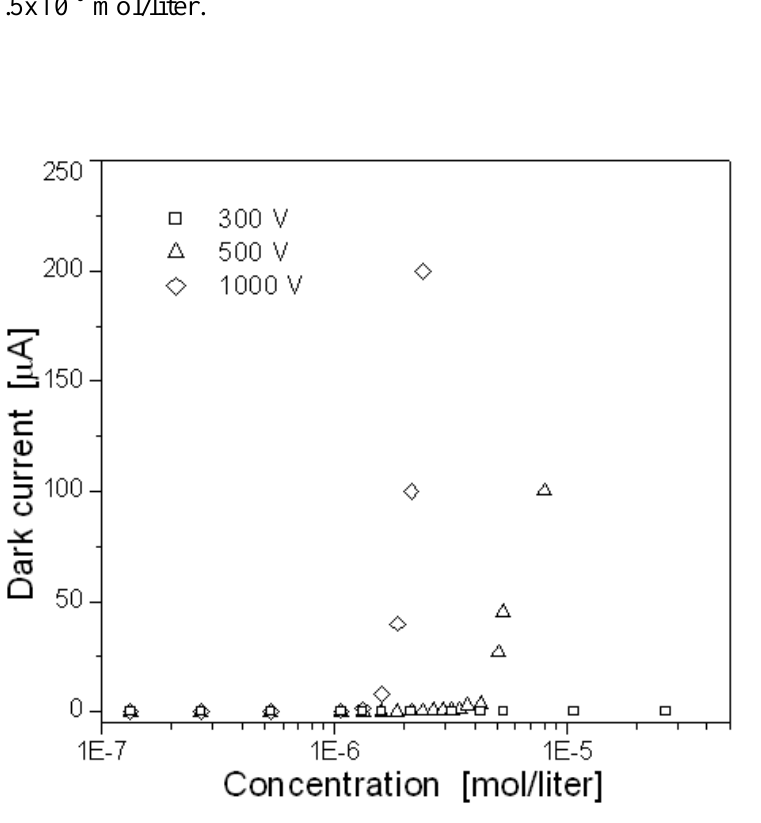
Figure 6. Dependence of the dark current on air concentration at different applied